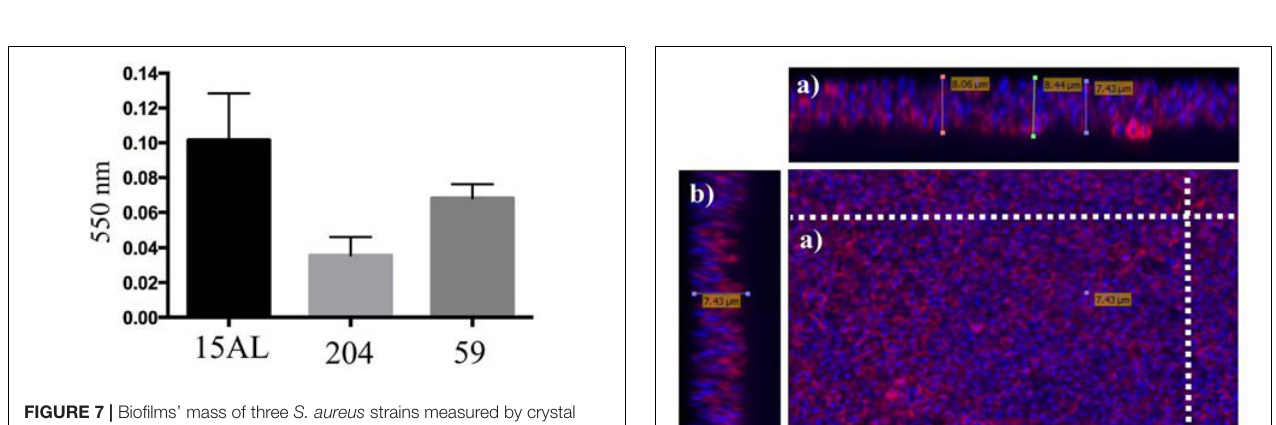
FIGURE 6 | Colocalization of PHMB-FITC with intracellular S. aureus 15 AL inside Mac-T cells. Mac-T cells were infected with S. aureus strain 15 AL followed by treatment with PHMB-FITC (green). Prior to microscopy, cells were labeled with DAPI (blue) and WGA (red). Upper panels are images of infected cells visualized using filters for DAPI, FITC, and WGA, and merged images. Lower panels are enlarged images that clearly show colocalization between PHMB-FITC (green) and S. aureus 15AL (blue dots). White scale bar is 25 µ M.